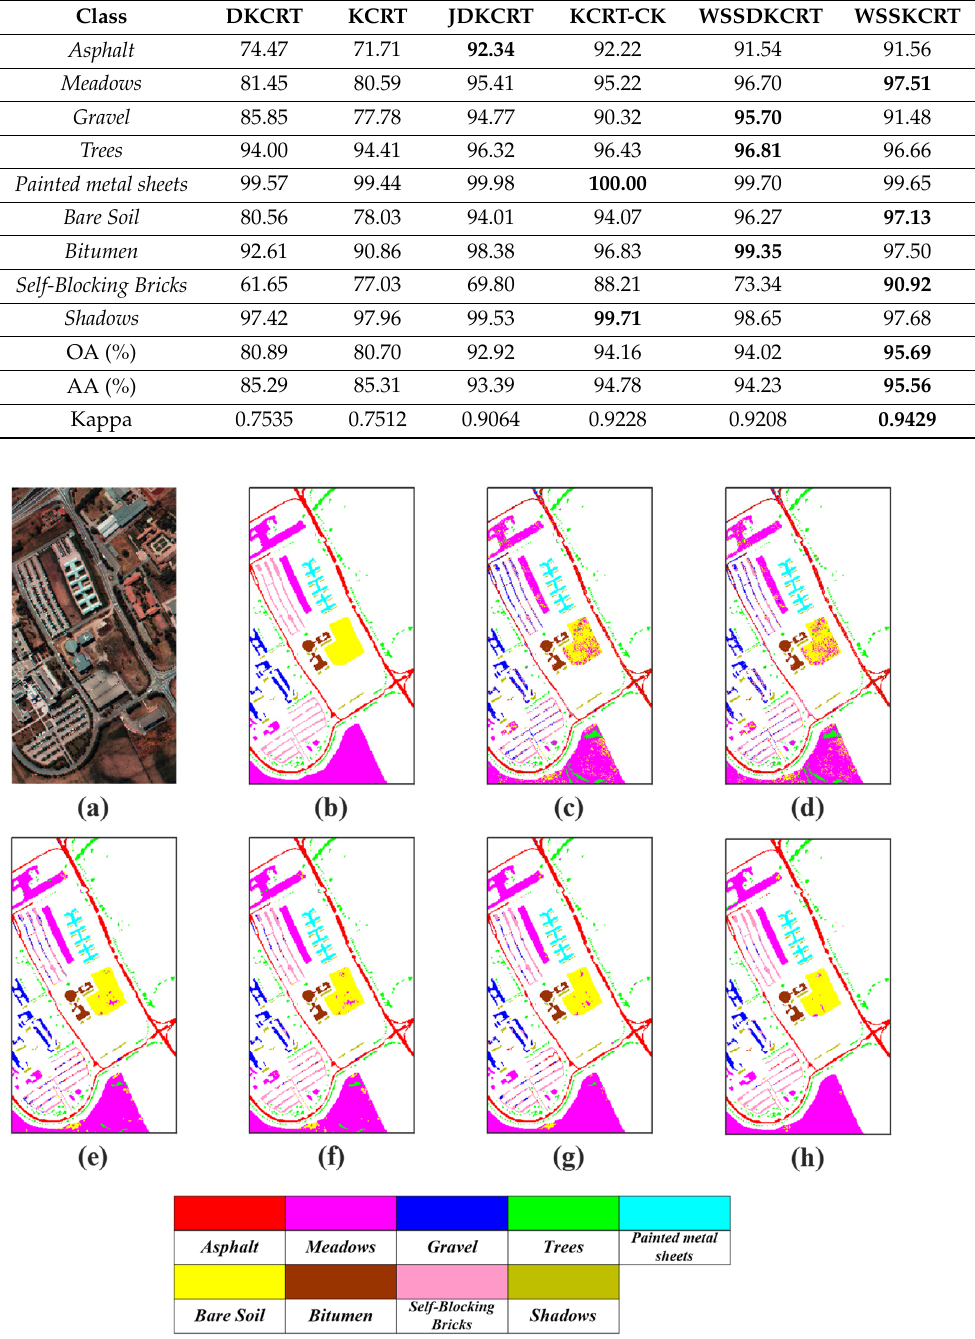
Figure 3. ( a ) False-color image, ( b ) ground truth, and land cover classification maps generated by ( c ) DKCRT, ( d ) KCRT, ( e ) JDKCRT, ( f ) KCRT-CK, ( g ) WSSDKCRT, and ( h ) WSSKCRT.